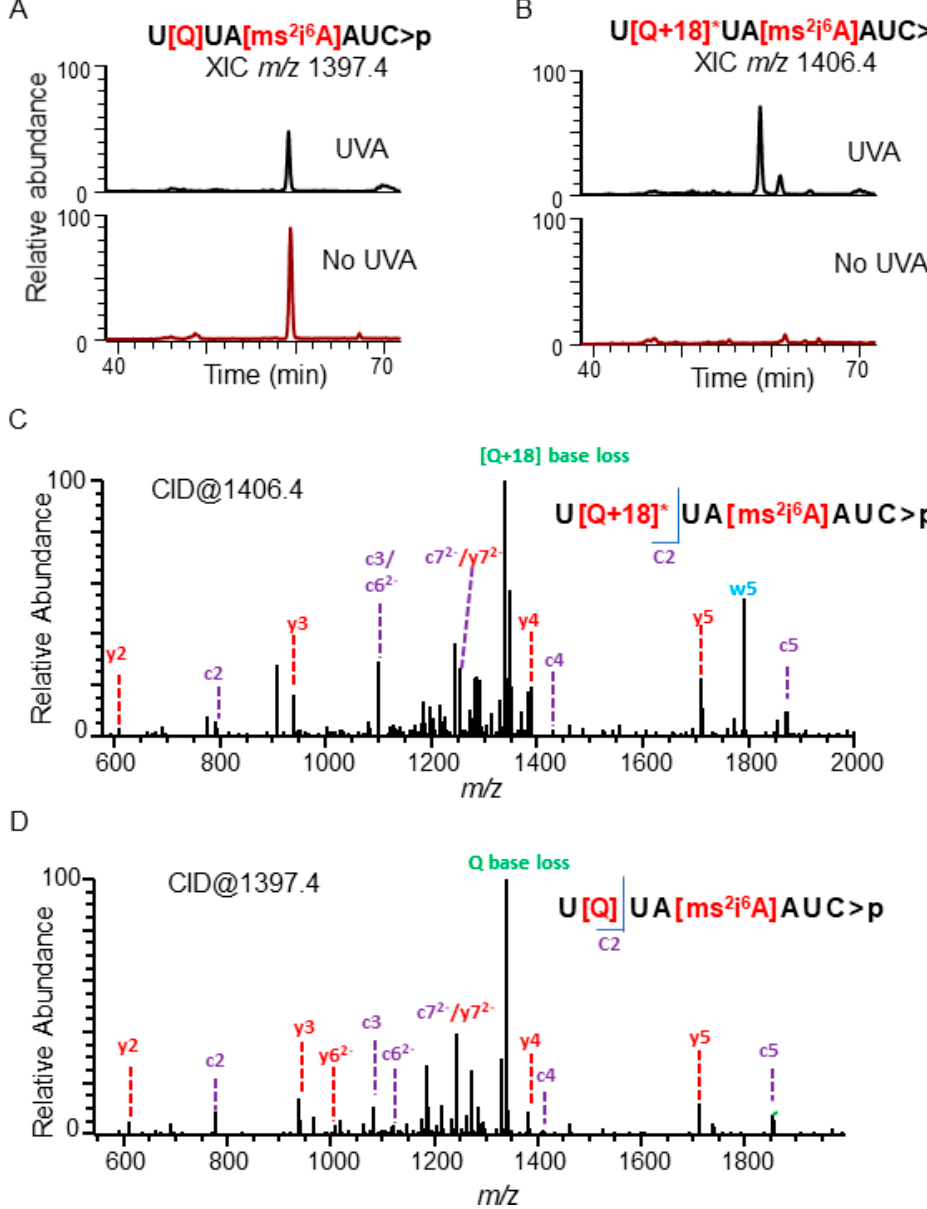
Figure 4. Chemical changes in the anticodon region of tRNA Tyr from UVA-exposed and unexposed E. coli cells. (A) Comparative levels of modified oligonucleotide, U[Q]UA [ms 2 i 6 A]AUC>p ( m/z 1397.4, position 33-40). ( B ) Comparative levels of modified oligonucleotide, U[Q+18]*UA [ms 2 i 6 A]AUC>p ( m/z 1406.4), ( C ) MS/MS spectrum of m/z 1406.4 depicting the sequence informative product ion (color coded c and y fragment ions as described in Figure 2) pattern of oligomer, U[Q+18]*UA [ms 2 i 6 A]AUC>p ( D ) MS/MS spectrum of m/z 1397.4 depicting the sequence informative product ion pattern of oligomer, U[Q]UA [ms 2 i 6 A]AUC>p. Most abundant fragment ion correspond to the loss of Queuosine-Q or Q+18 and their positions are depicted in red font in the oligonucleotide.